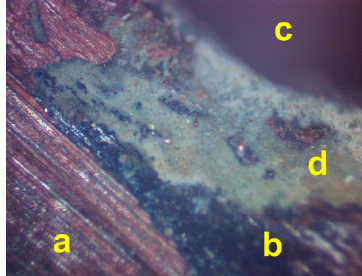
expanding porosity. Field of View = 0.937 mm.